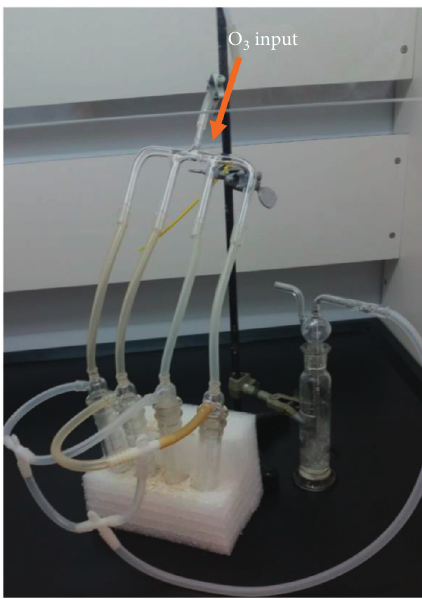
Figure 1: Device for the OAE. Four commercial glass (borosilicate 3.3, Pyrex ® ) midget impinger (25mL) tubes with fritted nozzles allow to analyze a sample by triplicate and a blank simultaneously. At the bottom, a flask (trap) containing Na 2 S 2 O 5 solution is placed to neutralize the excess of ozone gas and close the